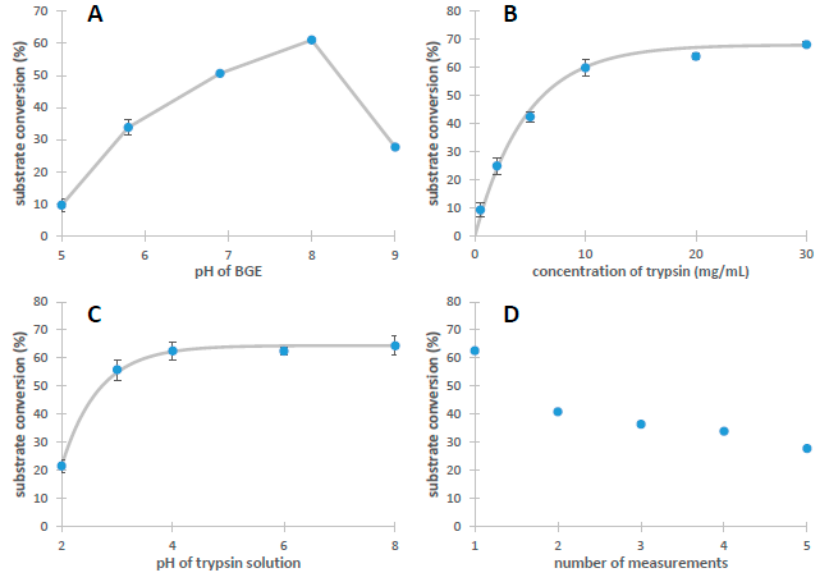
Figure 2. Parameters such as pH of the BGE ( A ), concentration of trypsin solution ( B ), pH of trypsin solution ( C ), and number of the measurements ( D ) affecting the activity of the reactor. Conditions were the same as in Figure 1. Preconditioning and injection parameters are detailed in Table S1.